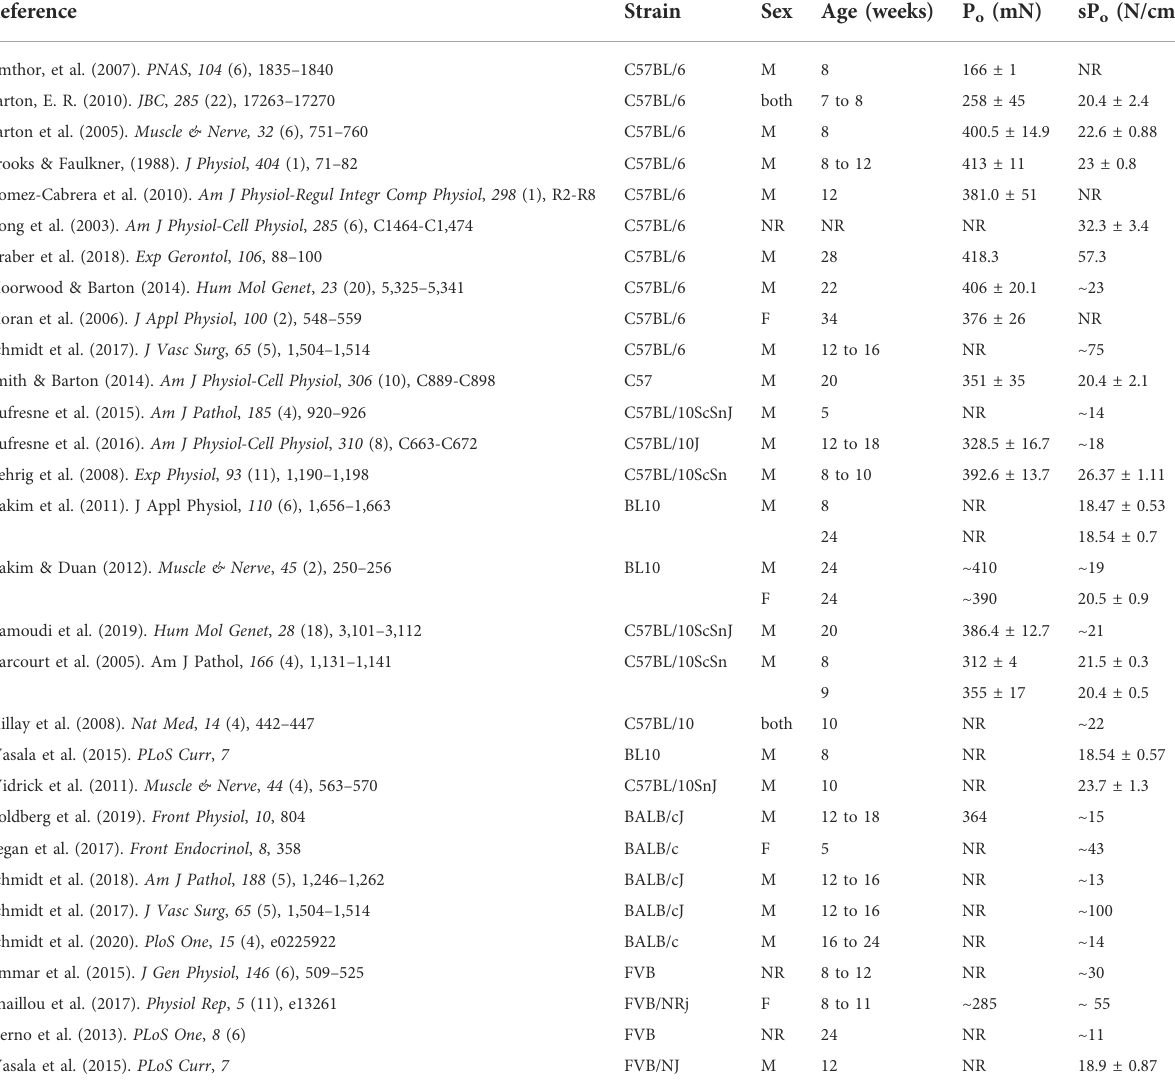
the following key terms —‘ mouse, ’ ‘ murine, ’ ‘ skeletal muscle, ’ ‘ contraction, ’ ‘ force, ’ ‘ C57BL/6, ’ ‘ C57BL/6J, ’ ‘ C57BL/6NJ, ’ ‘ BALB/cJ, ’ ‘ C57BL/10, ’ ‘ FVB/NJ.